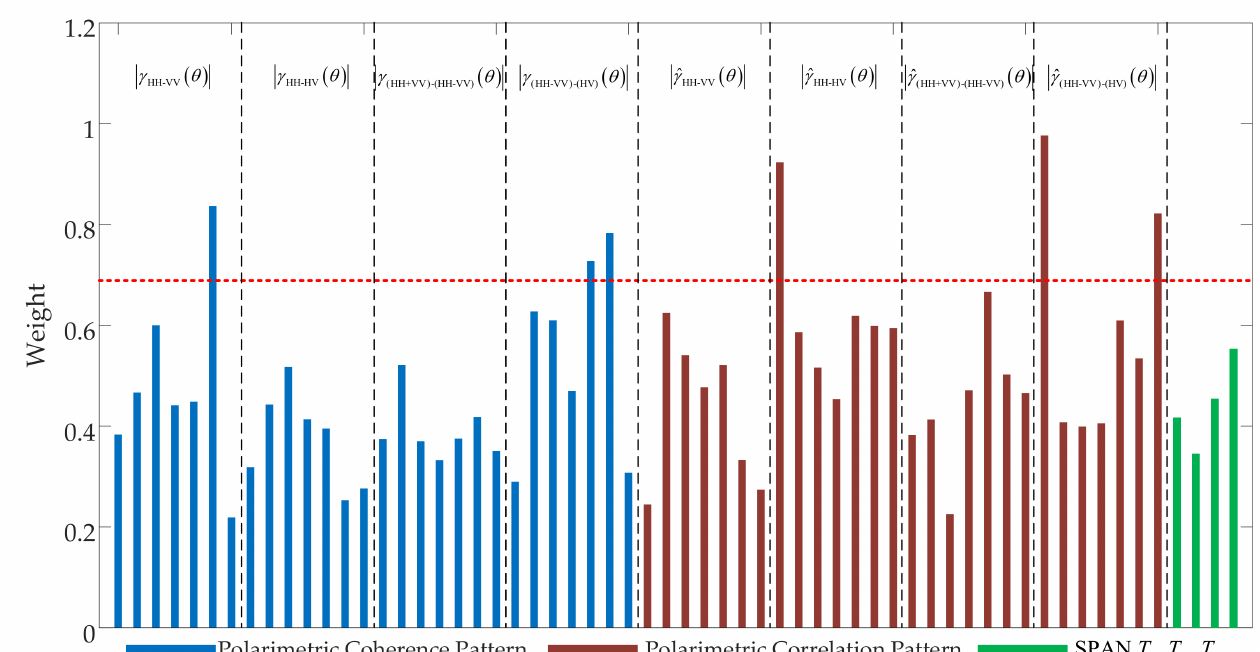
Figure 4. The weight of each feature from Radarsat-2 PolSAR dataset. From left to right are the weight of the original value, the standard deviation value, the contrast value, the anisotropy value, the mean value, the maximum value, and the minimum value in each group,